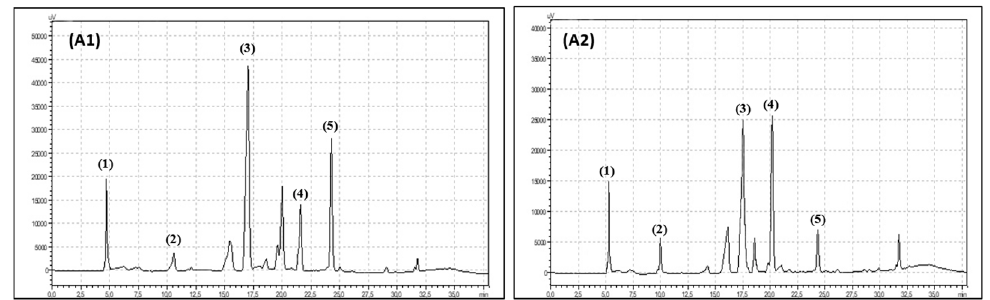
Figure2. Chromatogramshowingretentiontimesfororganicraspberry( A1 )andconventionalraspberry Figure 2. Chromatogram showing retention times for organic raspberry ( A1 ) and conventional leaves ( A2 ) phenolic acids: (1) chlorogenic acid, (2) ca ff eic acid, (3) salicylic acid, (4) p-coumaric acid, raspberry leaves ( A2 ) phenolic acids: (1) chlorogenic acid, (2) caffeic acid, (3) salicylic acid, (4) p- (5) ellagic coumaric acid, (5) ellagic acid.